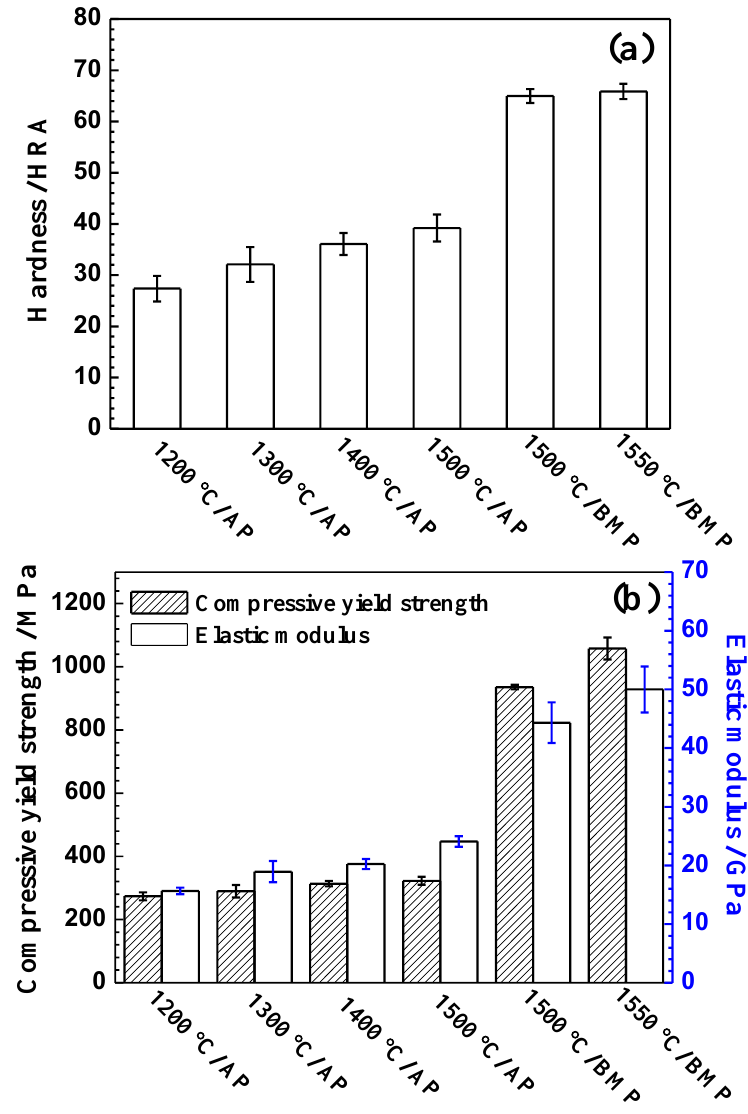
Figure 8. Mechanical properties of Ti-28Nb-34.5Zr alloy prepared with different sintering temperatures and powders: ( a ) Hardness; ( b ) Compressive elastic modulus and yield strength.